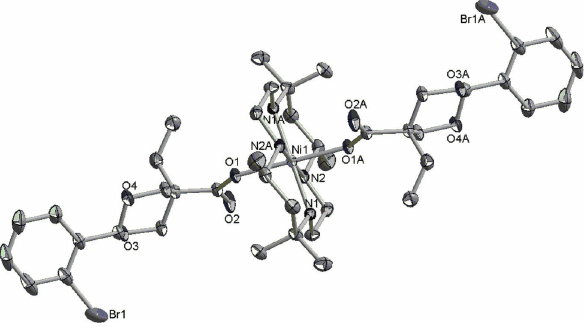
Table 1: Data collection and handling.